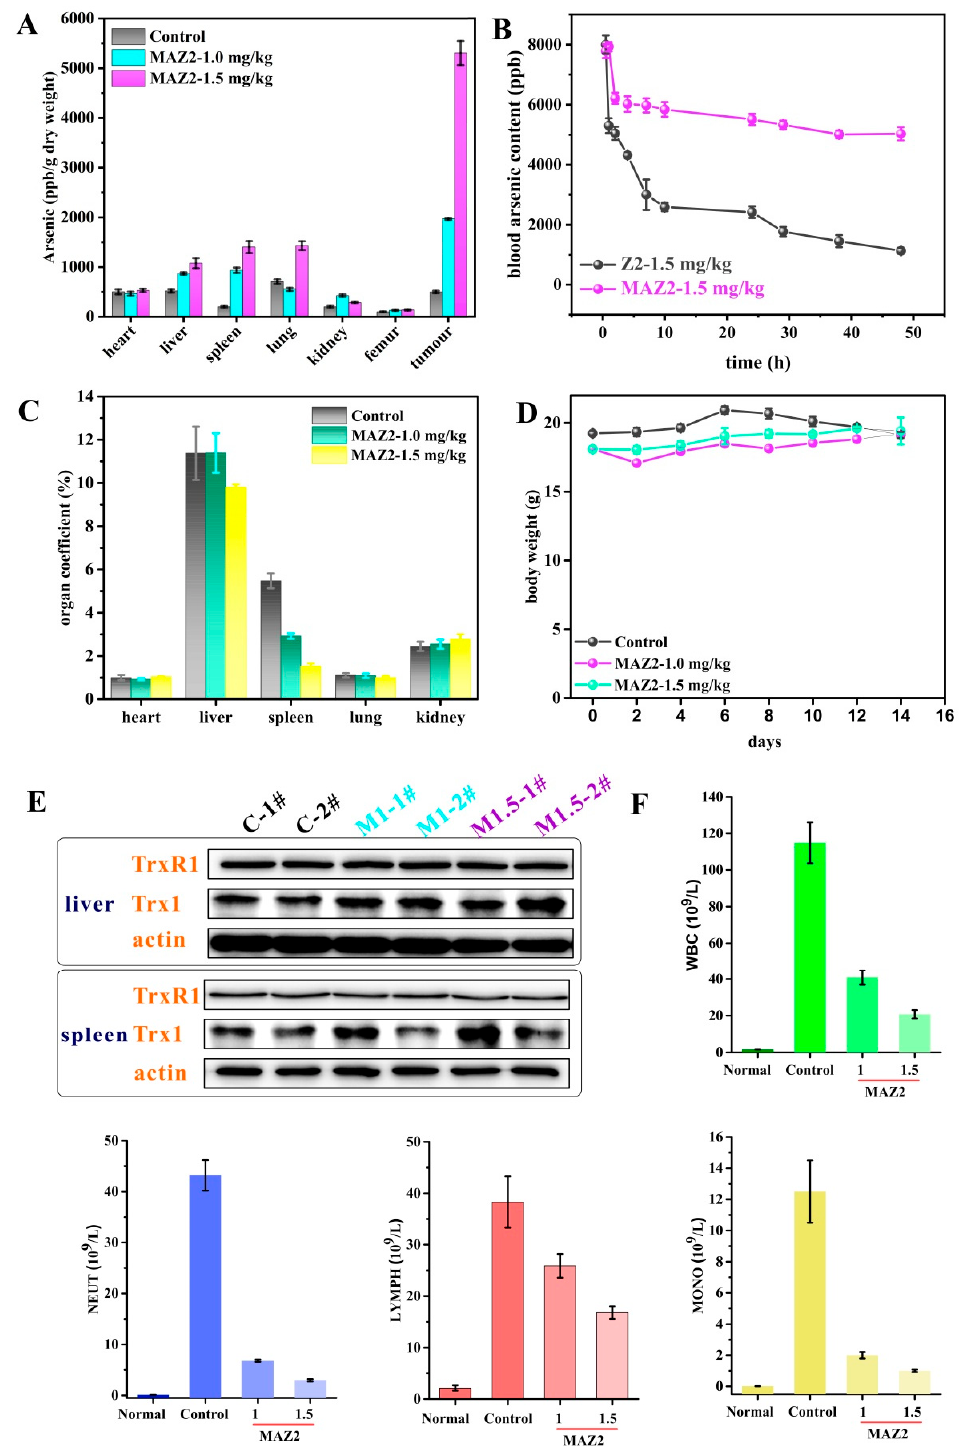
Figure 6. MAZ2 administration had no obvious side effects; ( A ) is the arsenic content; ( B ) is the blood arsenic content; ( C ) is the organ coefficient; ( D ) is the body weight; ( E ) is the TrxR and Trx content of the liver and spleen; and ( F ) is the blood cell counts.